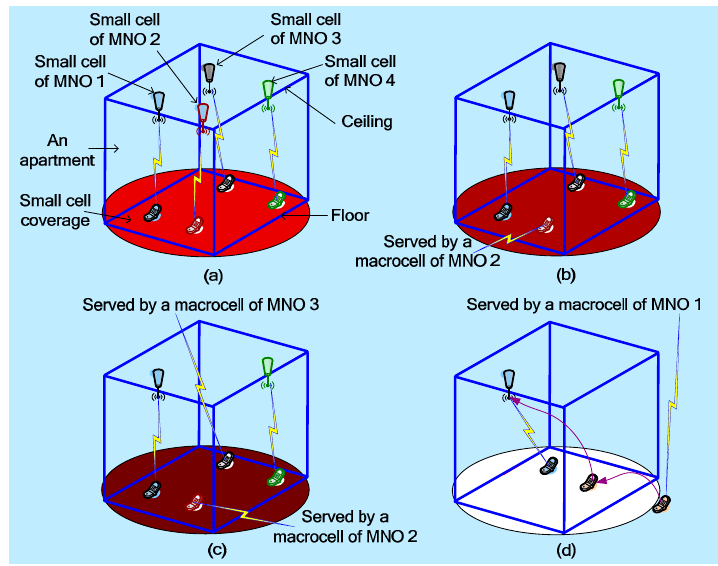
Figure 3. An illustration of the CCI strength when sharing the spectrum of one MNO (MNO 1) with that of others (MNOs 2, 3, and 4): ( a ) maximum CCI for x m = 4, ( b ) CCI for x m = 3, ( c ) minimum CCI for x m = 2, and ( d ) no CCI for x m = 1.